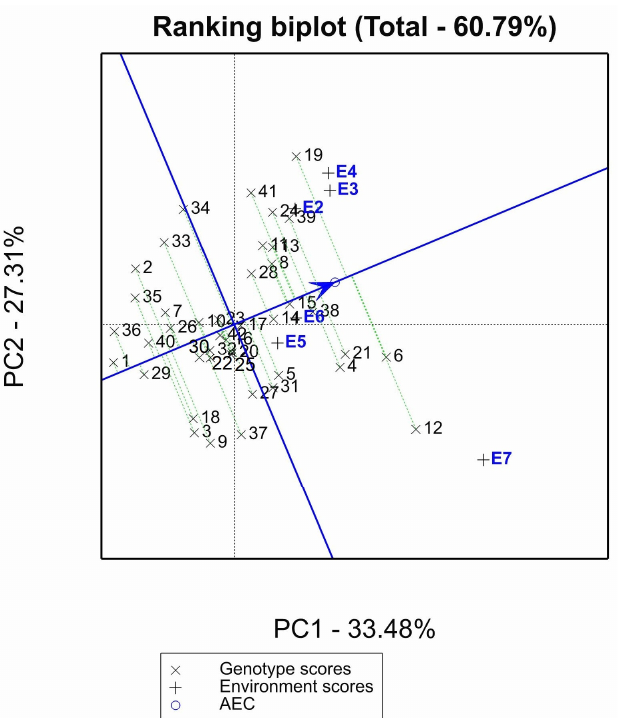
Figure 3. Average environment coordination (AEC) views of the GGE biplot show the mean yield performance and genotype stability. PC: principal component, E2: Marchouch-2016/17-imazethapyr at 75 g a.i. ha -1 , E3: Marchouch-2016/17-metribuzin at 210 g a.i. ha -1 , E4: Marchouch-2016/17-no herbicide treatment, E5: Terbol-2018/19-imazethapyr at 75 g a.i. ha -1 , E6: Terbol-2018/19-metribuzin at 210 g a.i. ha -1 and E7: Terbol-2018/19-no herbicide treatment. Accessions numbered 1 to 42 are listed in Table 5.